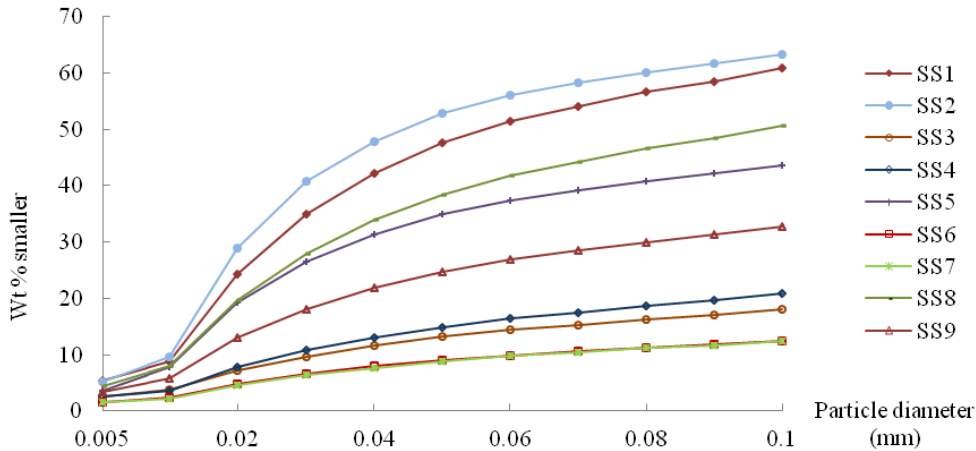
Figure 2. Particle diameter distribution of suspended